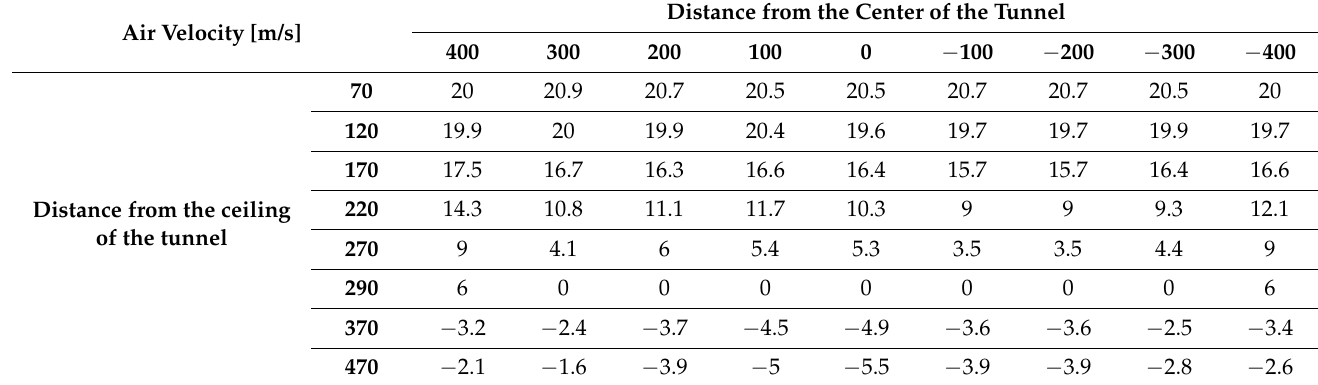
Table 3. The air velocity in measuring area T2; beam height of 288 mm; fan step IC20 (the data recorded with thermo-anemometer type SDL300).